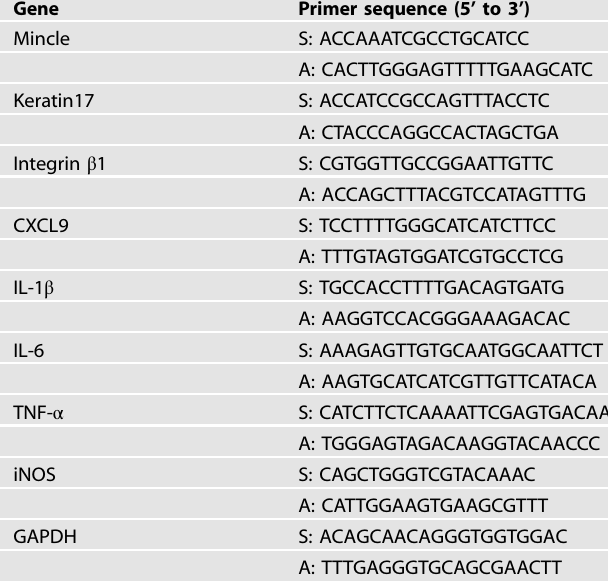
Table 1. Speci fi c primers for real-time PCR.